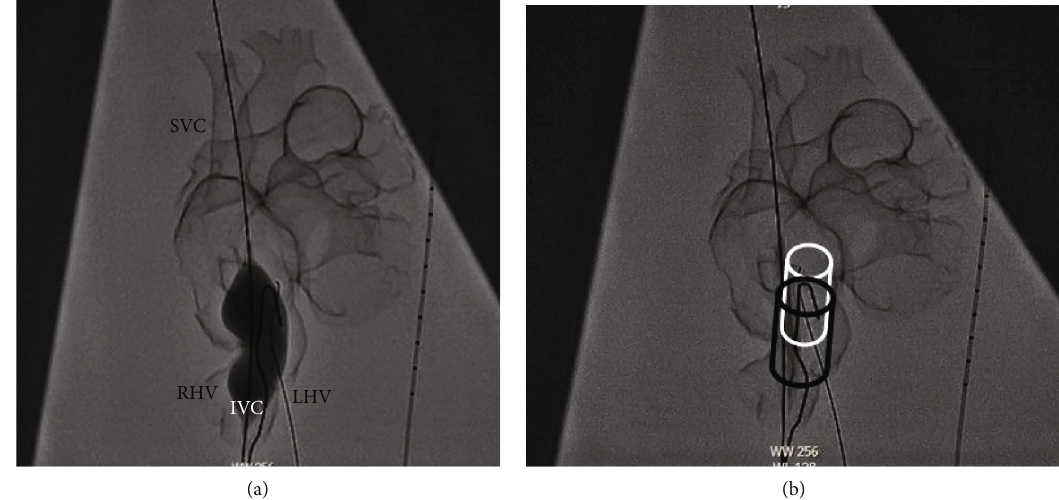
Figure 5: A 3-dimensional model was created to simulate balloon sizing in the inferior vena cava (IVC) (a). The critical point at the IVC- right atrium junction was 20.3mm. A decision was made to position a 24 mm anchored bare stent (black outlined stent) at this location (b). A long wire was placed in the superior vena cava (SVC), and a short wire was placed in both the left hepatic vein (LHV) and the IVC. The aim of the placement of the bare stent (black outlined stent) and the subsequently positioned covered stent (white outlined stent) was to cover the sinus venosus defect and to ensure no obstruction of blood fl ow in the LHV and the right hepatic vein